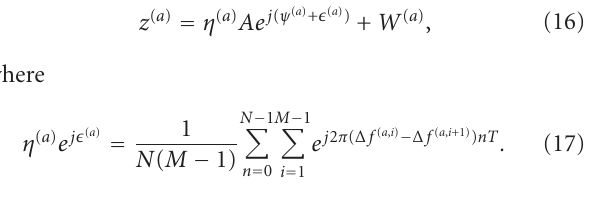
accumulated over N samples. In fact, if Δ f ( a , i ) / = Δ f ( a , i +1)